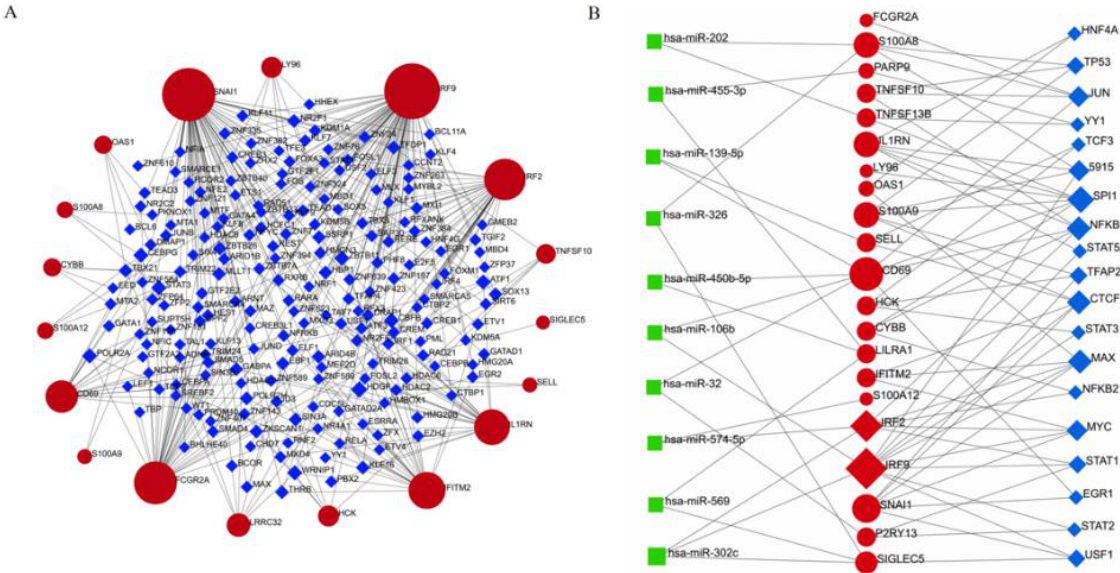
Figure 5. The construction of TF–DEG and TF–DEG–miRNA co-regulatory networks. ( A ) TF–DEG interactions network visualization. The network contained 215 nodes and 325 edges. Common DEGs were marked in red. TF genes were marked in blue. ( B ) TF–DEG–miRNA co-regulatory network identification. The network included 50 nodes and 82 edges. There were 10 miRNAs (green) and 19 TF genes (blue) in the network, and they interacted with common DEGs (red).